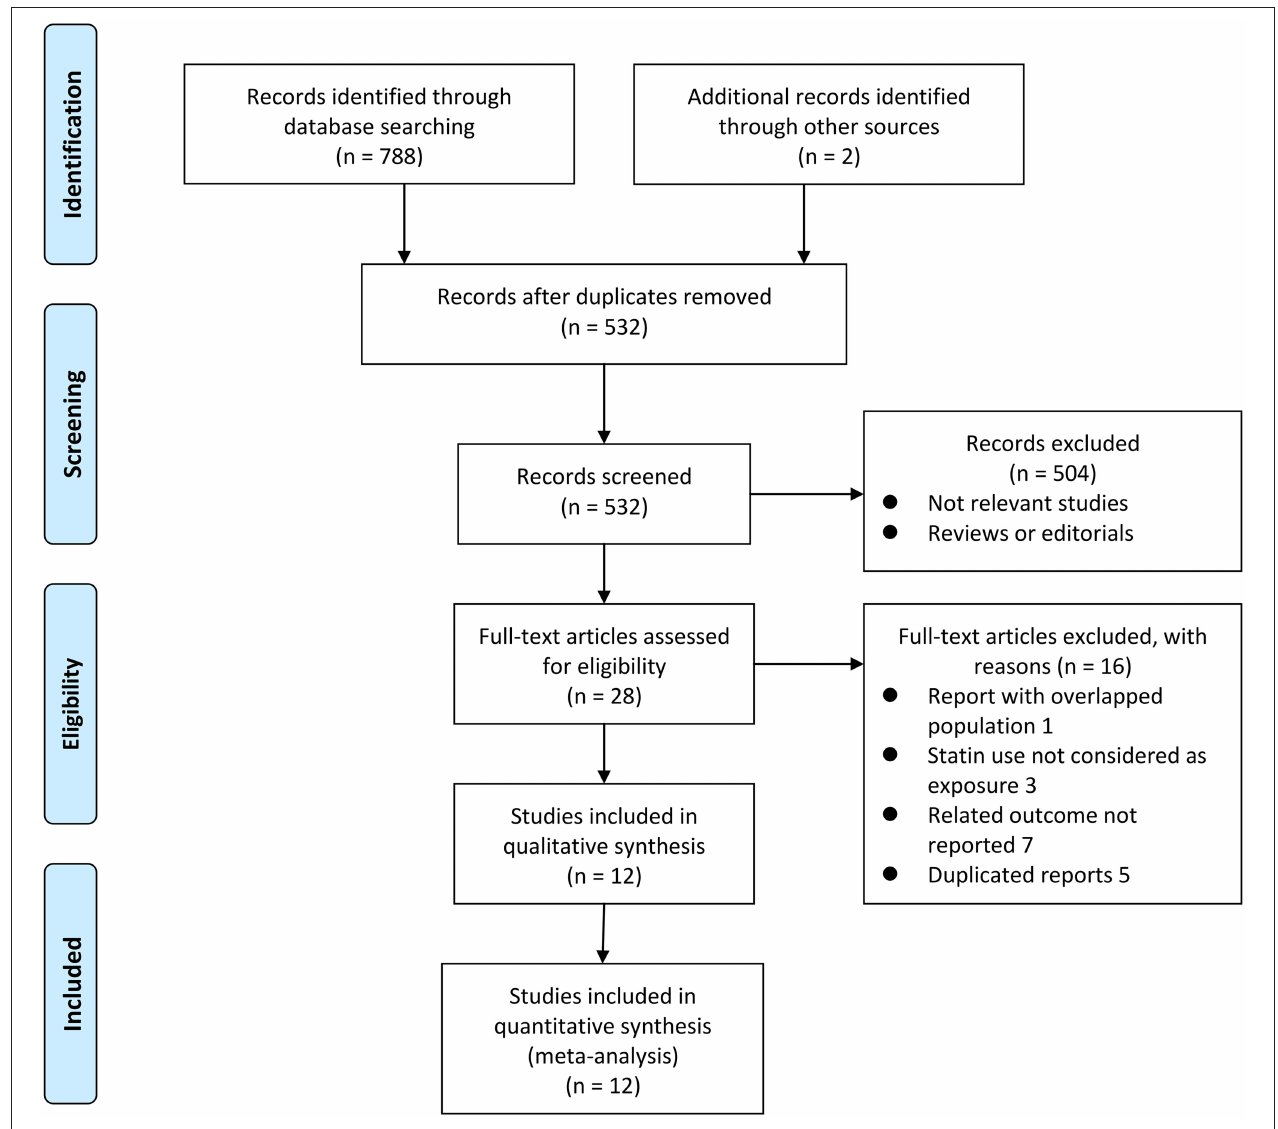
FIGURE 1 | Flowchart of literature